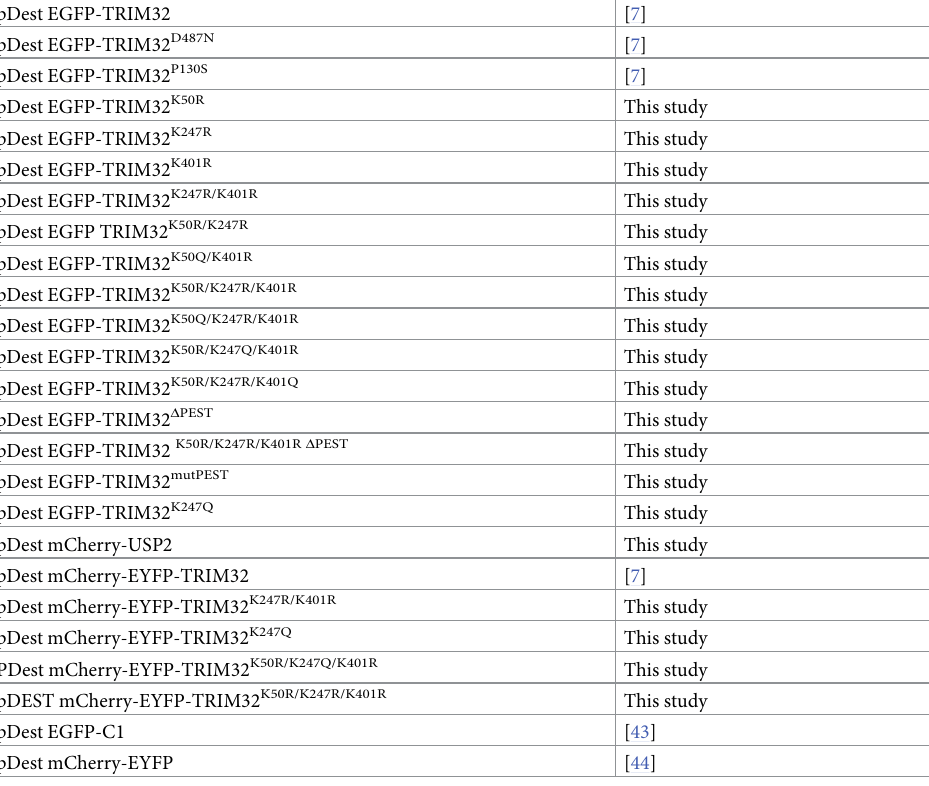
Table 1. Plasmids used in this